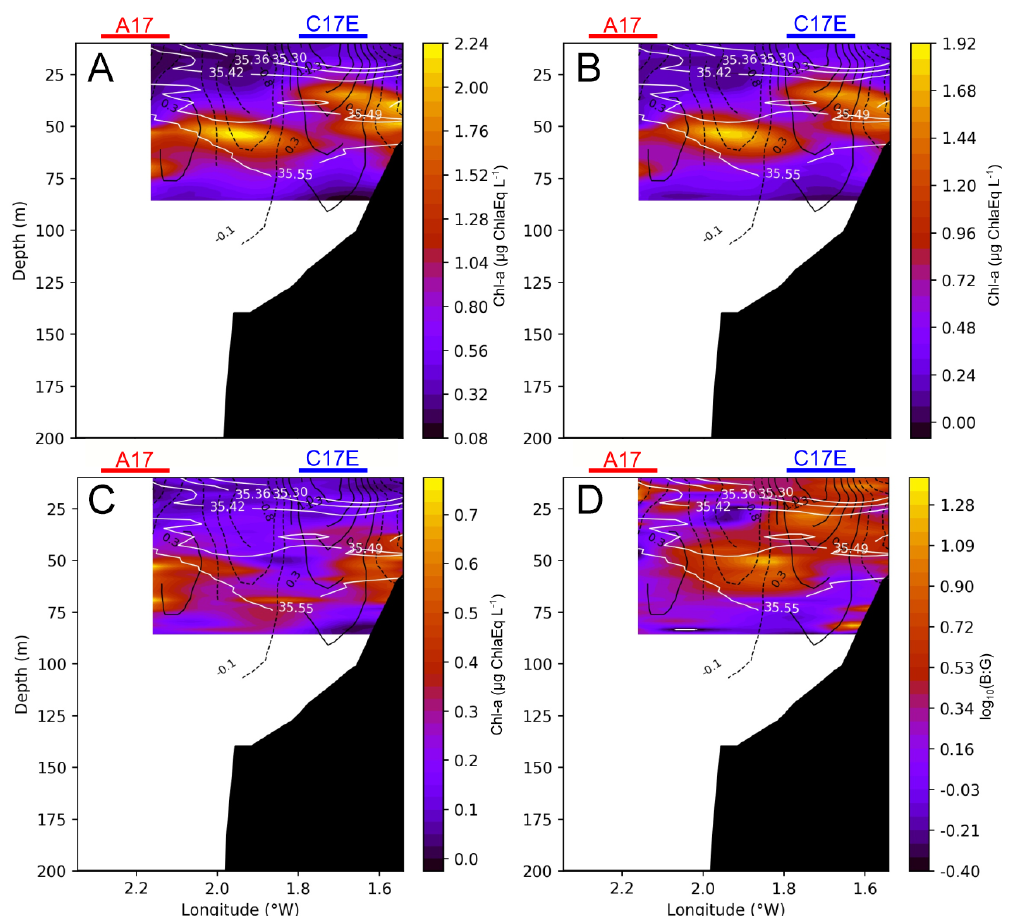
Figure 7. Cross section at 43.77 ◦ N (location marked by dashed lines in Figs. 1 and 4; same section as in Fig. 5) of total chl a (a) , brown chl a (b) , green chl a (c) , and the brown chl a to green chl a ratio (B : G), which has been logarithmically transformed (d) for the chosen period (2 to 4 August 2017). White lines represent salinity contours, and solid black lines represent positive vorticity values or cyclonic circulation, while dashed lines represent negative vorticity values of anticyclonic circulation. The red and blue horizontal lines represent the horizontal extension of A17 and C17E, respectively, that the section